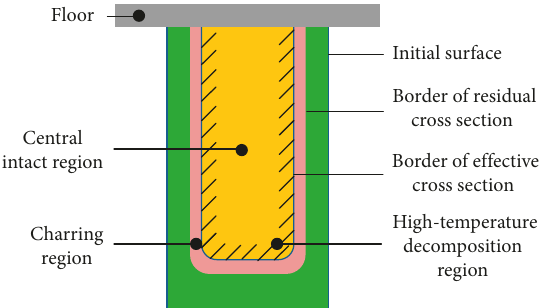
Figure 1: Sketch map of charring wood beam after exposed to fire from three sides.